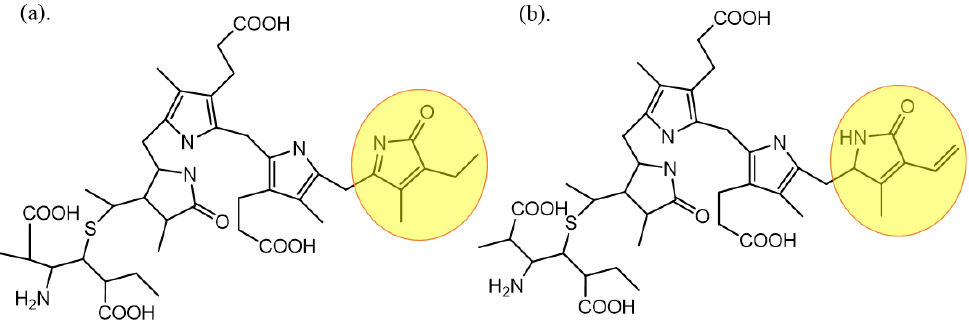
Figure 1. The structure of PCB ( a ) and PEB ( b ) (the structural differences are highlighted). PC is usually a mixture of monomer, trimer, and hexamer in the solution. PC monomer is composed of α and β subunits, in which α subunit contains 162 amino acids and β subunit contains 172 amino acids [49]. The chromophores are covalently bound to the Cys84 of the α subunit and to the Cys82 and Cys153 of the β subunit, named α 84, β 84, and β 155, respectively. Due to the different numbers of charged residues on the polypeptide chain, the local structures of chromophores are various [50]. The α or β chains of PC are composed of nine helixes (X, Y, A, B, E, F’, F, G, and H) and form α and β subunits, respectively. Through electrostatic interaction between α and β subunits, monomer of αβ is formed, as shown in Figure 2a. The helical X and Y in α and β subunits formed partially overlapped and crescent-shaped monomer ( αβ ) by hydrophobic and ion–dipole interaction, and three monomers of αβ form a disc-shaped trimer ( αβ ) 3 with central cavity around the central axis, as shown in Figure 2b. Regarding the interaction between α subunits, two ( αβ ) 3 trimers with combinations of face-to-face form monoclinic PC hexamer ( αβ ) 6 , as shown in Figure 2c. The molecular structure and spatial conformation of PC affords it its own special spectroscopic properties.